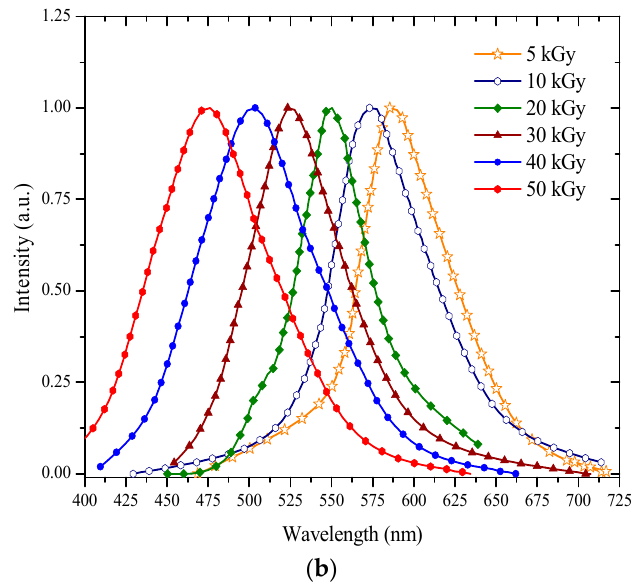
Figure 4. ( a ) Fluorescence spectra of MEH–PPV at 50 μ M concentration, pre- and post-gamma irradiation ranging from 5 to 30 kGy; ( b ) Fluorescence spectra of BMP at 1 mM concentration, pre- and post-gamma irradiation ranging from 5 to 50 kGy. Table 1. ( a ) The details of BMP fluorescence, ASE peak wavelength (nm), peak intensity (a.u.), and blue shift occurring due to gamma radiation and full width half maximum (FWHM) of ASE when pump energy was 11 mJ; ( b ) The details of MEH–PPV fluorescence, ASE peak wavelength (nm), peak intensity (a.u), and blue shift occurring due to gamma radiation and full width half maximum (FWHM) of ASE when pump energy was 8